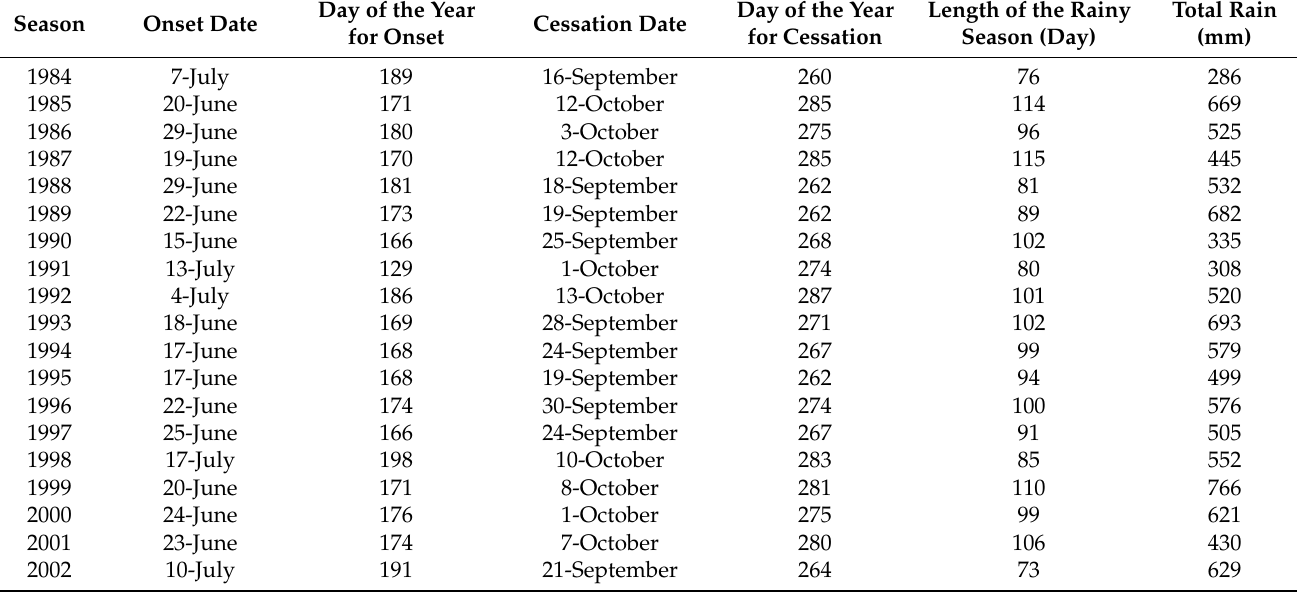
Table 4. Estimated length of the rainy season (1984–2018) for Gedaref State,